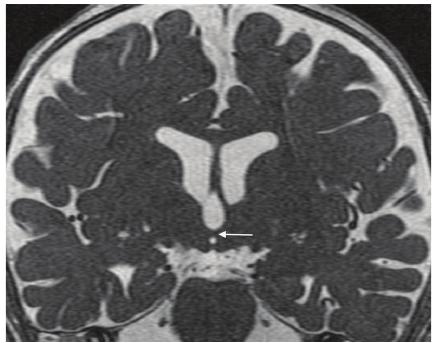
Figure 1: Sagittal FSPGR BRAVO T1WI (repetition time msec/echo time msec/inversion time msec, 10/4/450) showing a nodular parenchymal band in the third ventricle at the level of the hypothalamus between the anterior commissure and mammillary body (arrow). The pituitary infundibulum, adenohypophysis, and neurohypophysis are normal. Note metallic susceptibility artifact in the roof of the oral cavity from prior cleft palate repair.